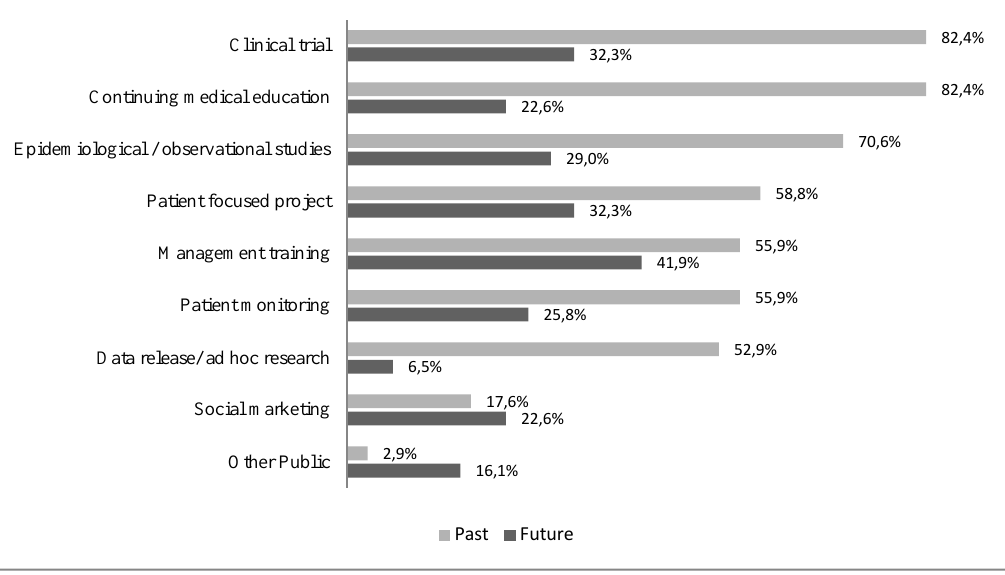
Figure 1: Percentage of ASLs Outsourcing Complementary Activities per Period